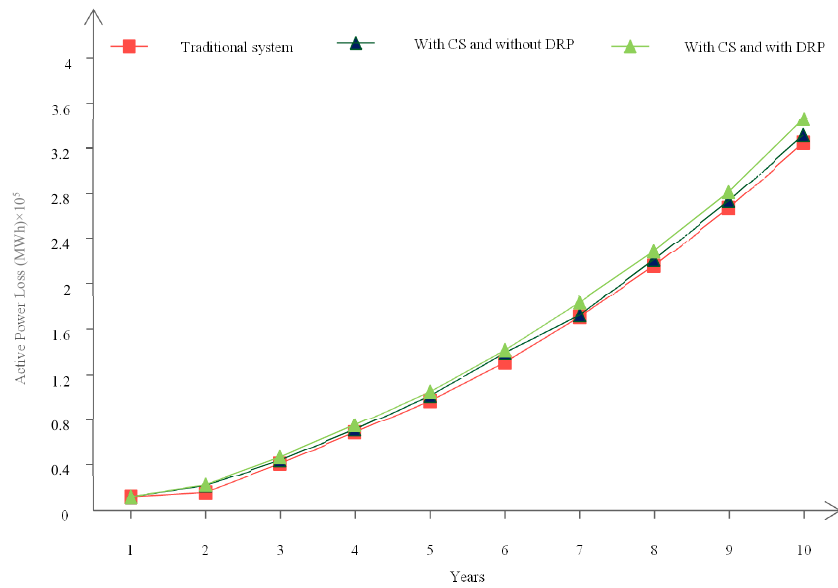
Figure 11. The amount of energy lost by the studied network in different scenarios. Additionally, the proposed method can decrease the network peak and modify the network load curve in the first year and subsequent years and control the load growth well. According to Figure 12, it can be seen that the proposed method has reduced the network peak in the best possible way among the scenarios (Figure 13). Results are ob ‐ tained for the two solar parking lots that had the best costs. The results show that with the increase in load in all cases, the network losses increase with a sharp slope, but solar park ‐ ing can significantly inhibit load growth. Moreover, the proposed method utilization in the first year reduces about 13% of the peak load. About 4% of it is for the share of the load management program, and 9% is related to the share of charge/discharge control programs for electric vehicles. Additionally, the proposed method can increase the load more effectively during non ‐ peak hours and improve the load factor. Figure 12. Load curve of the studied network in different scenarios and application of 10 ‐ year load growth. To better understand the effect of the proposed method on load growth, Figures 13 and 14 of the standard year and tenth year voltage curves are shown by considering the load growth in different scenarios. As shown, load management and locating the electric